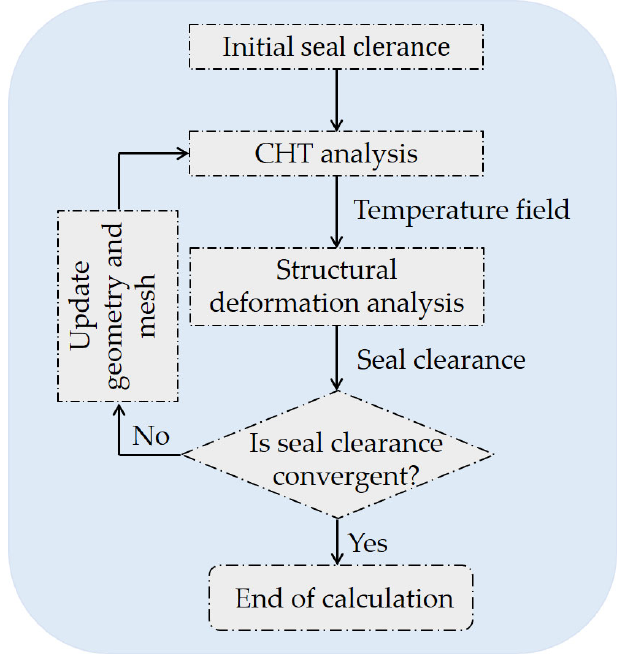
Figure 5. Solution process.